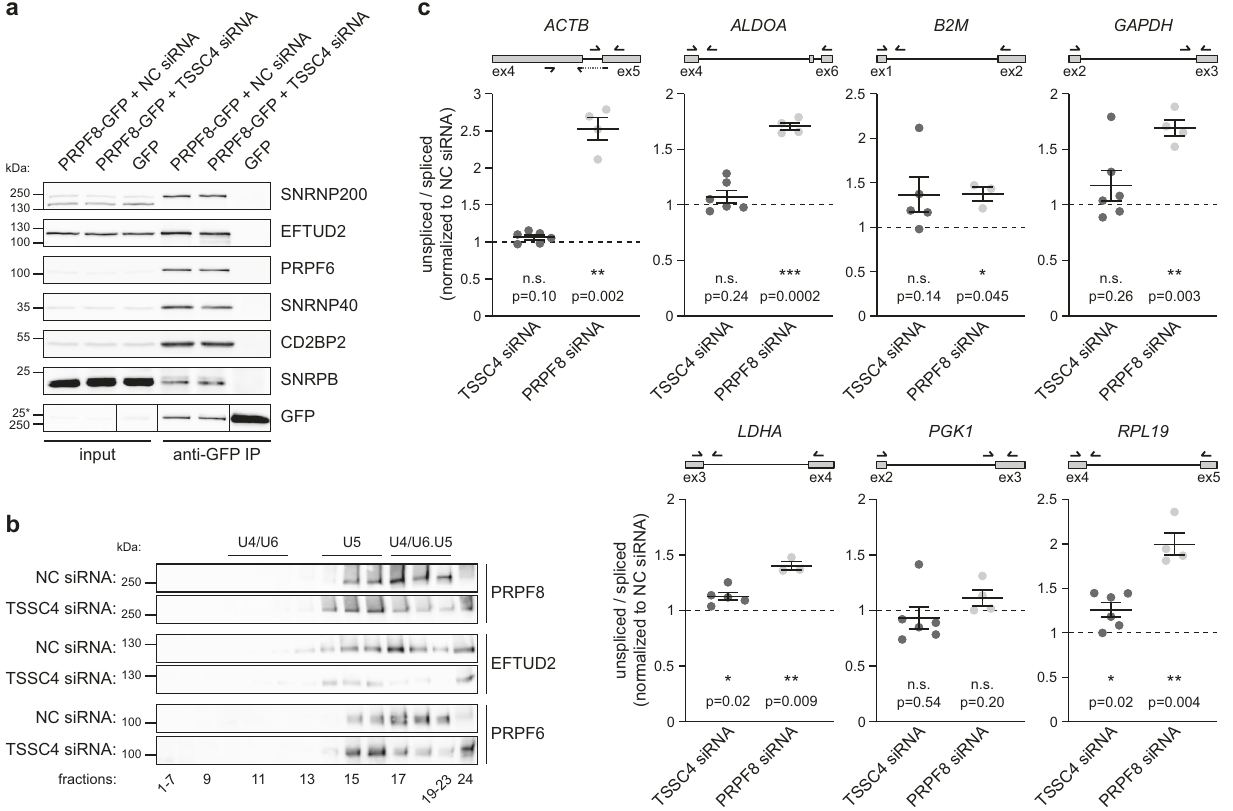
Fig. 7 TSSC4 does not affect U5 snRNP composition but promotes tri-snRNP assembly. a TSSC4 downregulation does not change the U5 snRNP protein composition. Co-immunoprecipitation of U5-speci fi c proteins with PRPF8-GFP was assayed after TSSC4 knockdown by western blotting. The positions of molecular weight markers are shown, the marker labeled by asterisk applies only to the GFP sample in the bottom combined GFP panel. b Sedimentation of U5-speci fi c proteins is altered after TSSC4 knockdown and all three U5 markers migrate in lighter fractions than in control extracts. The positions of molecular weight markers are shown. a , b The experiments were performed three times with similar results. Uncropped and unprocessed scans are provided in the Source Data fi le. c Splicing ef fi ciency is not globally reduced after TSSC4 downregulation. Total RNA was isolated, reverse transcribed, and analyzed by qPCR. The knockdown of PRPF8 served as a positive control. Mean and SEM from at least three biologically independent experiments are shown (in each experiment reverse transcription was performed in two technical replicates and the average value used for calculations). Statistical signi fi cance was determined by the paired two-tailed T test, P values are shown. Values for graphs are provided in the Source Data fi le. See also Supplementary Fig. 4 for knockdown ef fi